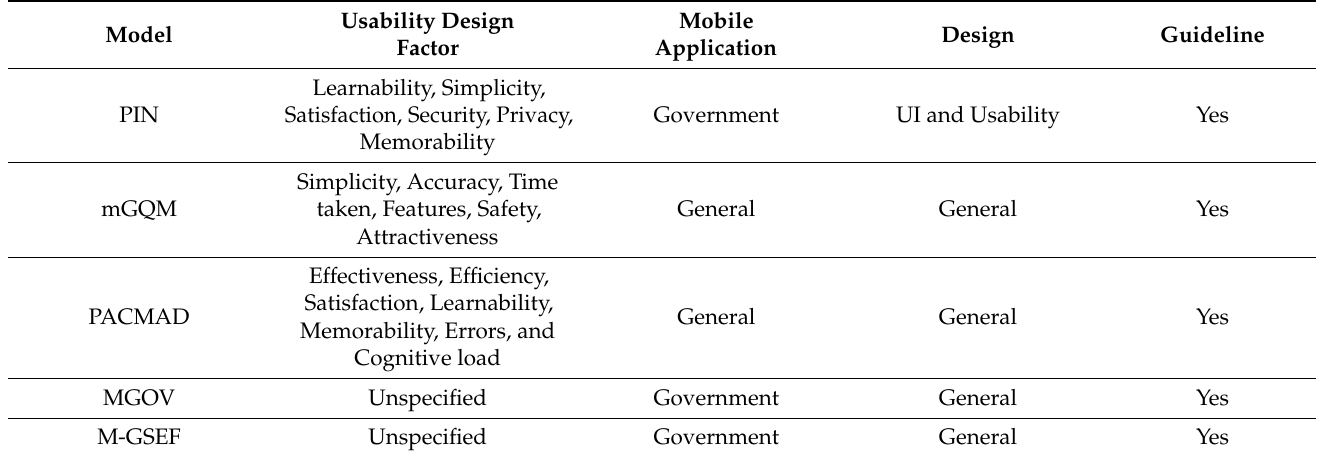
Table 20. A comparison of usability models for mobile government